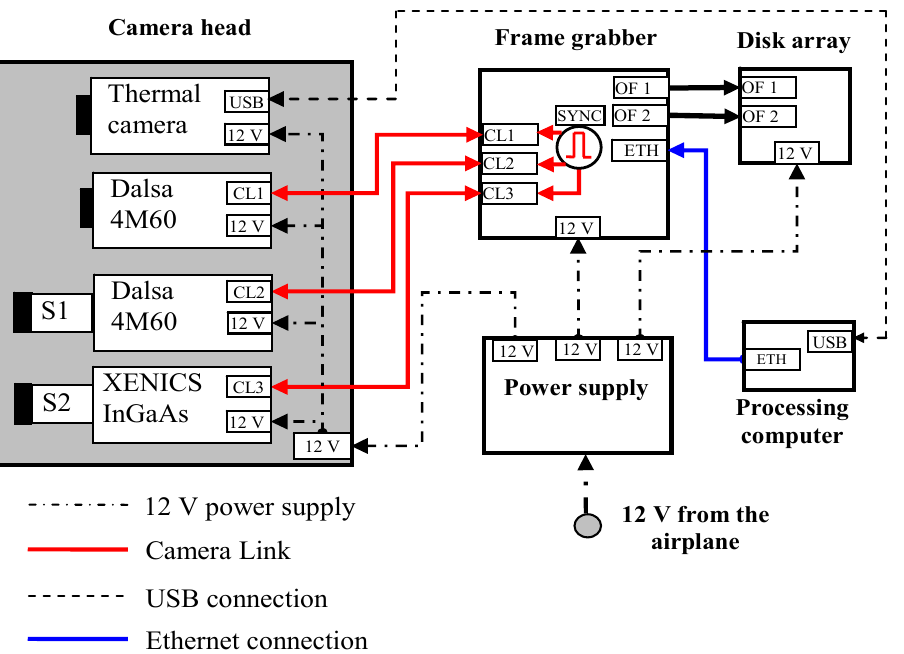
Figure 3. Diagram of the hyperspectral device with two spectrometers. CL stands